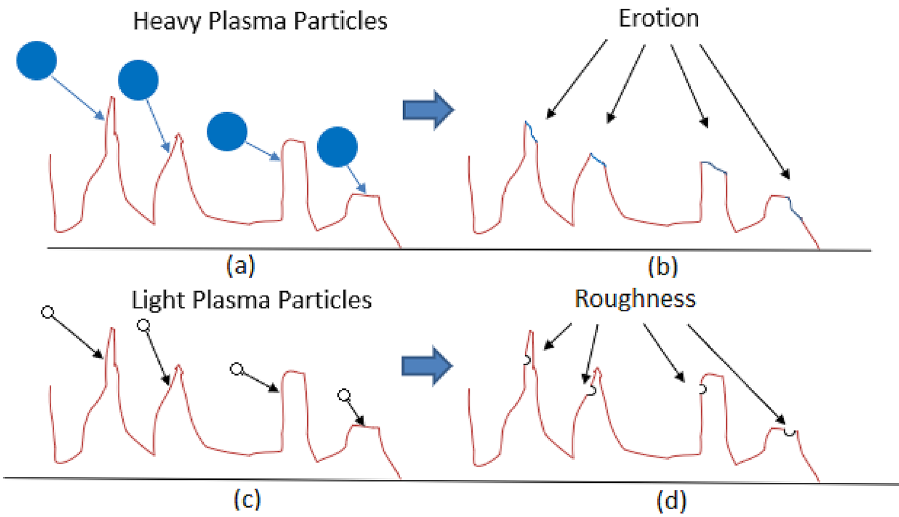
Figure 9. (a) Heavy plasma particles (Air or Argon plasma) collide with the humps of surface altitude fluctuation. (b) Heavy plasma particles erode the bumps and smooth the surface (erosion). (c) Lighter plasma particles (Helium plasma) collide with the humps of surface altitude fluctuation. (d) After colliding light plasma particles with the bumps, they create pits of their size in the humps, which causes more surface